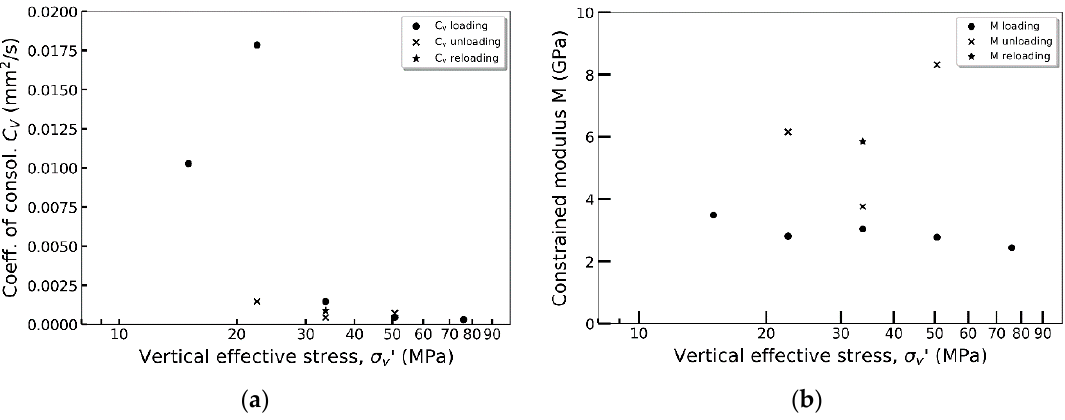
Figure 4. ( a ) The coefficient of consolidation and ( b ) the constrained modulus versus effective vertical stress from the oedometer incremental loading test of the vertical Draupne sample.